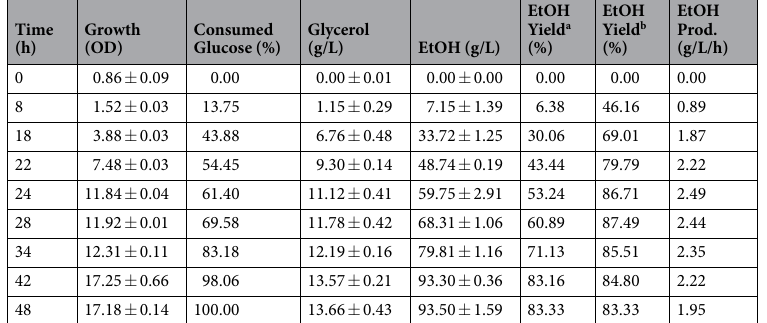
Table 4. HPLC analysis for fermentations conducted in 15-L bioreactors using SW-YPD media and the marine strain S.cerevisiae AZ65. a Calculated as a percentage of the theoretical yield (0.51) based on the total glucose (220 g). b Calculated as a percentage of the theoretical yield (0.51) based on the utilised glucose at the time of